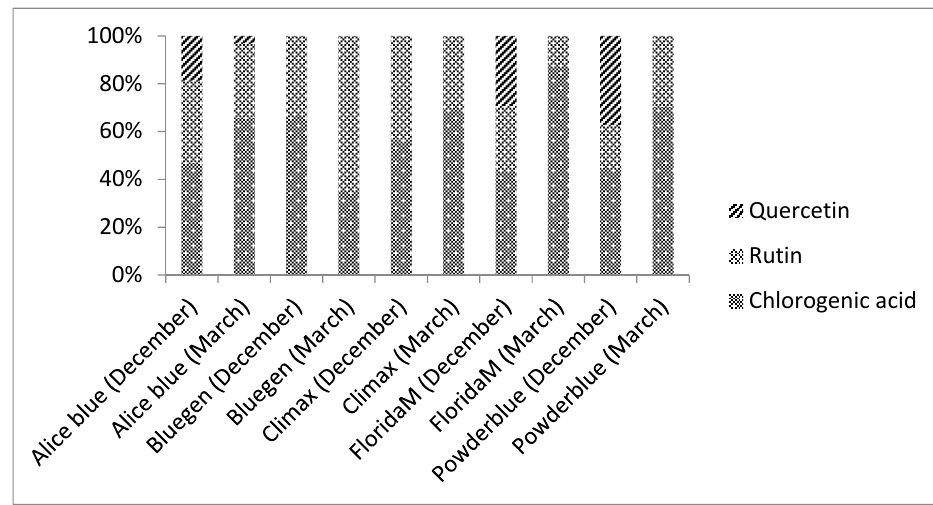
Figure 2. Percentages of the phenolic compounds chlorogenic acid, rutin and quercetin of rabbiteye blueberry leaves from different harvesting months and cultivars by HPLC-UV/DAD.